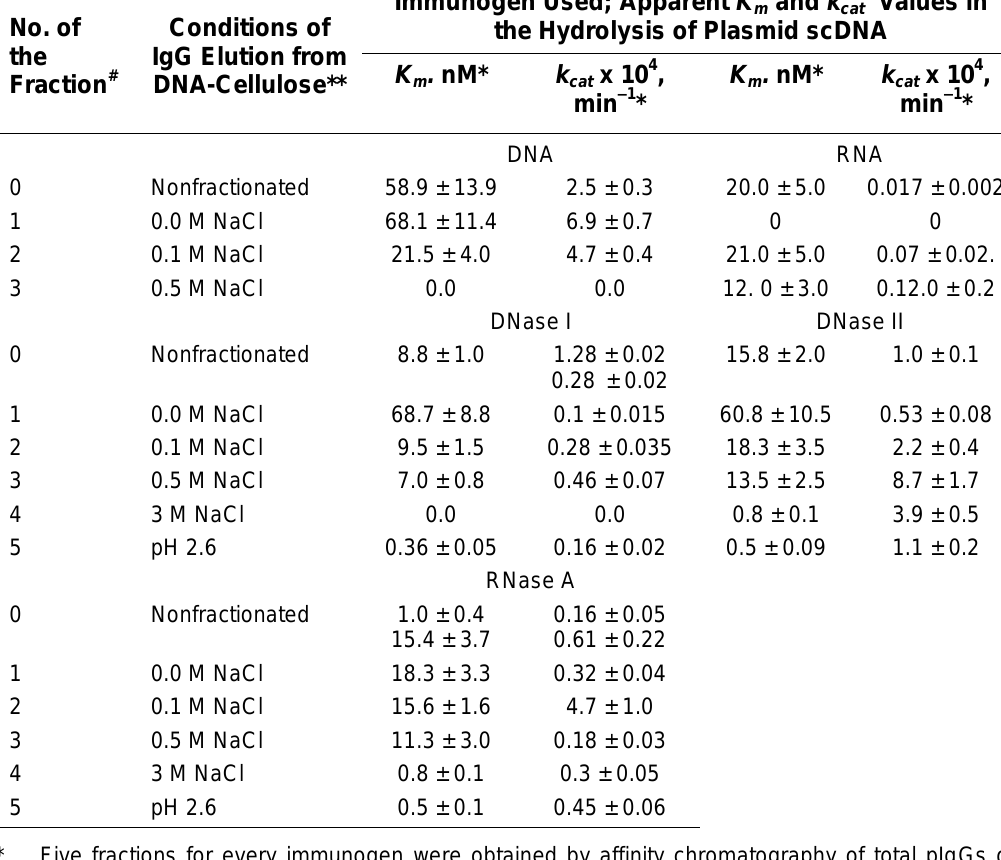
K and k Values Characterizing Five pIgG Fractions (Fig. 1) from the Sera of Rabbits m cat Immunized with DNA, RNA, DNase I, DNase II, and RNase A in the Hydrolysis of